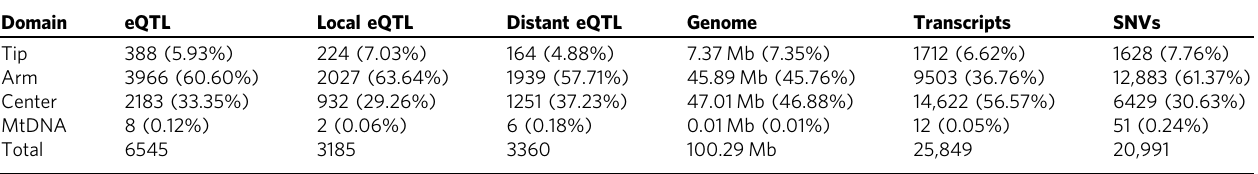
Table 1 The distribution of eQTL and SNVs.